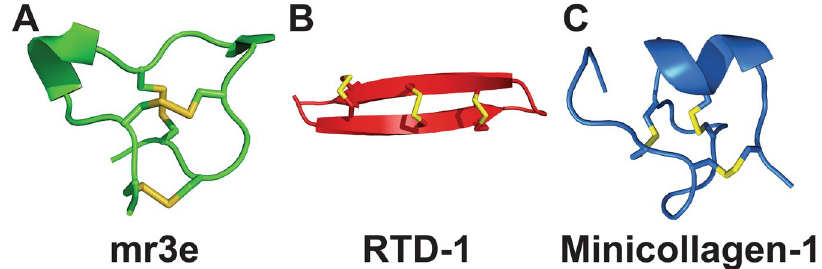
Figure 1. Animal hyperdisulfide-constrained peptides. ( A ) M-1 conotoxin mr3e from the marine cone snail Conus marmoreus (PDB: 2EFZ), ( B ) θ -defensins RTD-1 from Rhesus macaque (PDB: 2LYF) and ( C ) minicollagen-1 from the jellyfish Hydra sp . (PDB: